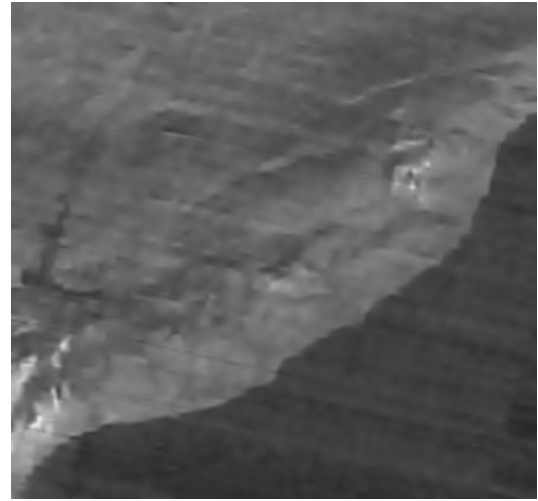
Figure 2. The output of the DCT-based filter.